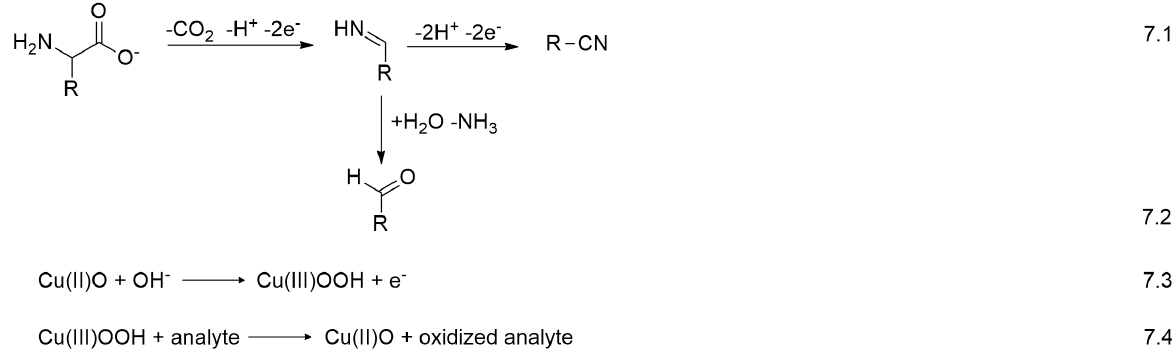
O nanoparticles by 7.1(Dong et al. 2008) and 7.2 (Alizadeh and Mirzagholipur 2